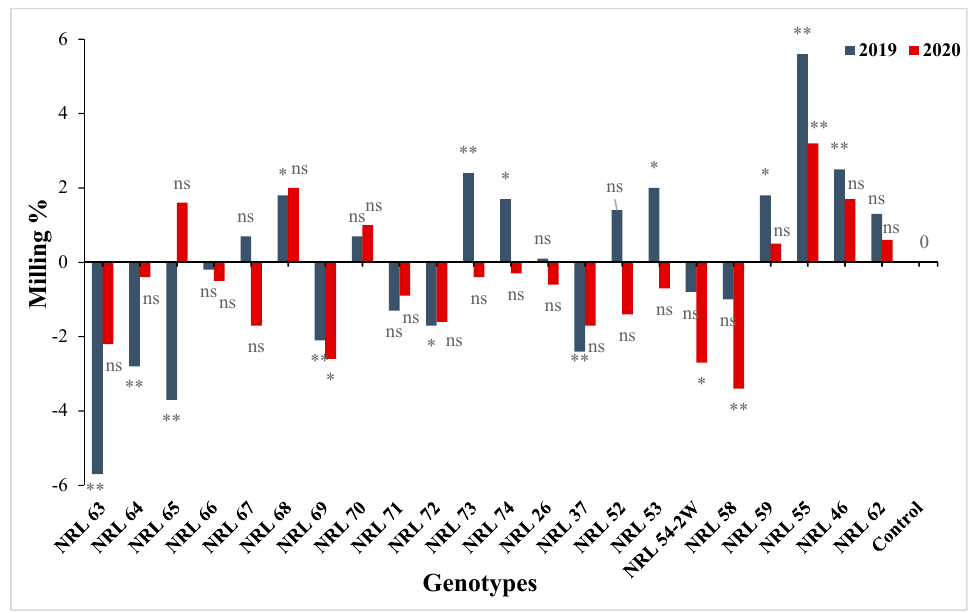
Figure 10. The percentage of advantage over commercial variety for grain yield/plant of studied genotypes during the 2019 and 2020 growing seasons. Means **: Highly significant at 1%; *: Signifi- cant at 5%; ns: Non-significant.